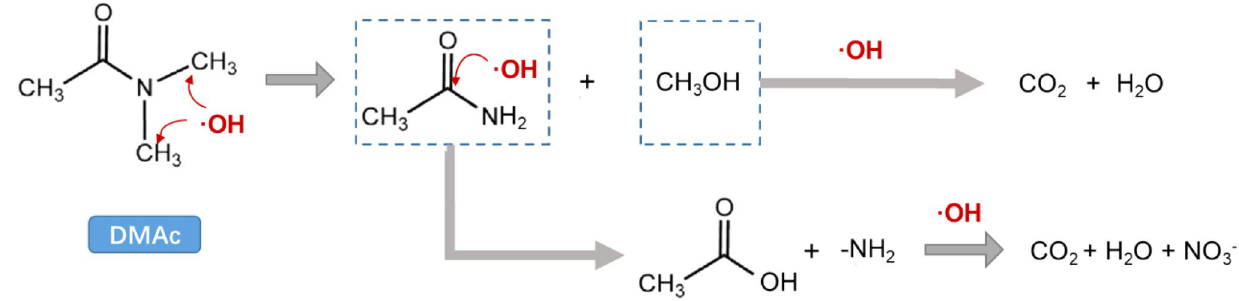
Fig. 10 Proposed degradation route of DMAc organic pollutant in wastewater by membrane Fenton process with neutral